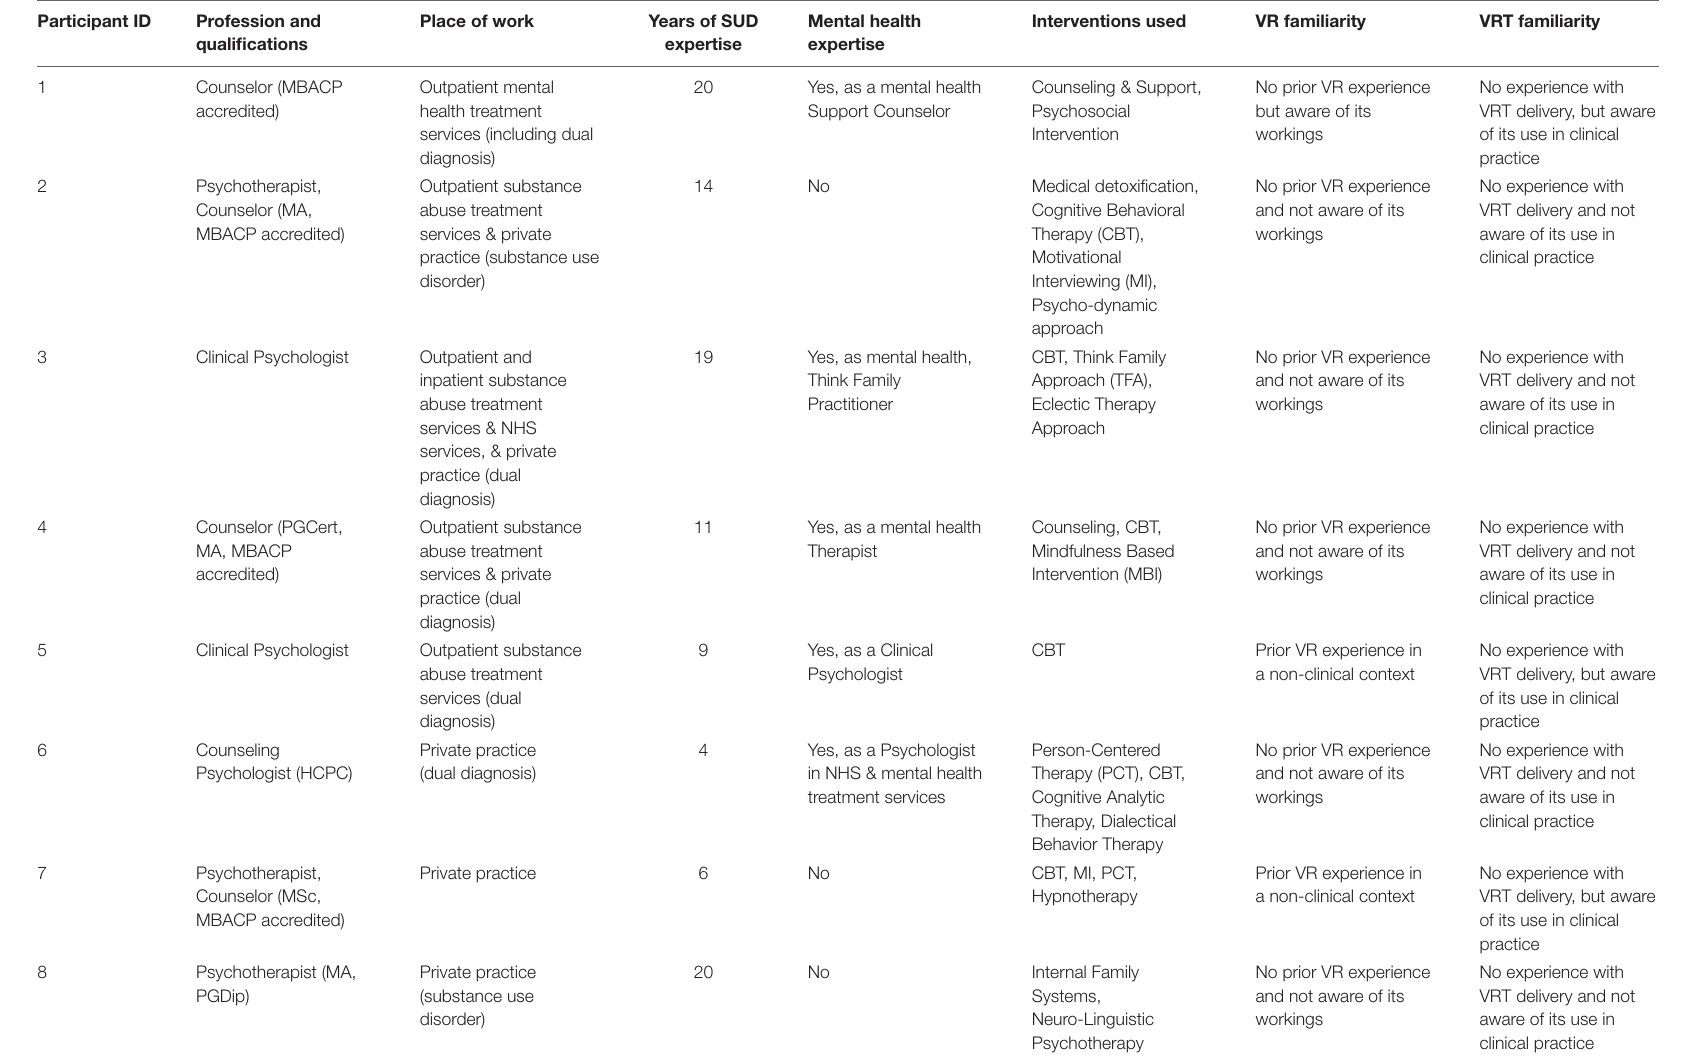
TABLE 1 | Descriptive data for